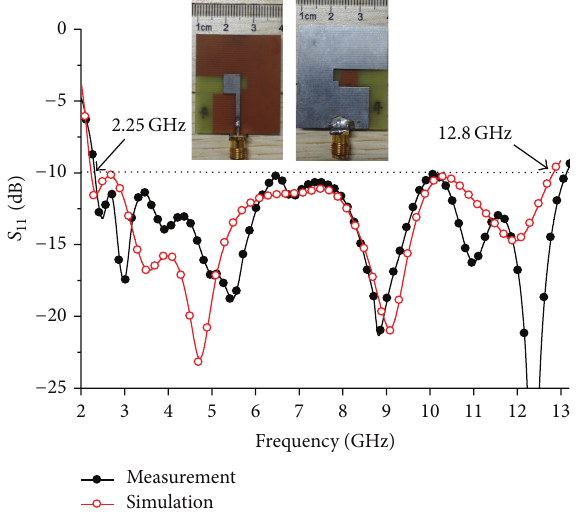
Figure 6: Magnitude of the scattering parameter S 11 versus frequency of the proposed